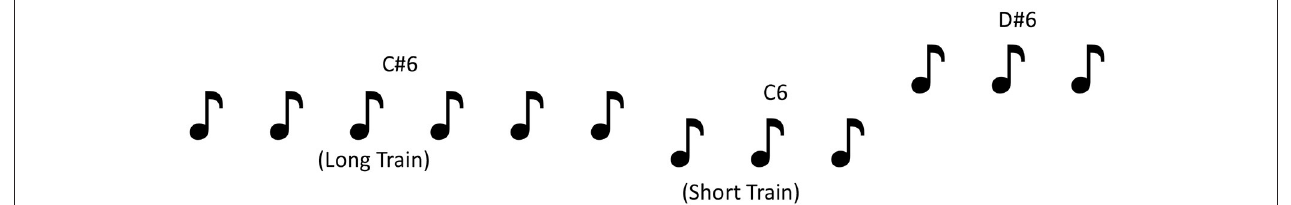
FIGURE 1 | Illustration of the roving pitch paradigm used in the EEG task.